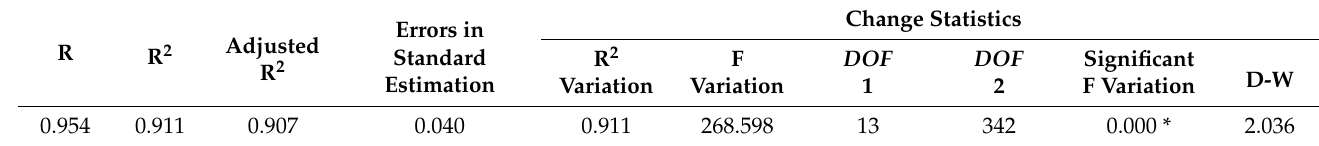
Table 6. Top-down model